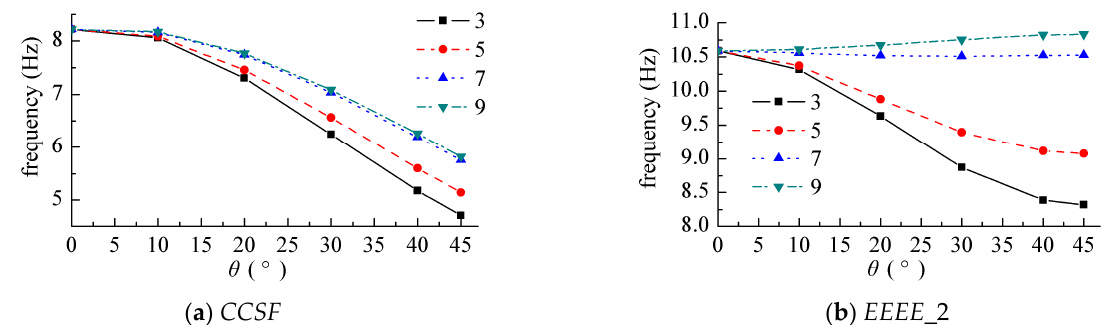
Figure 11. Natural frequency parameters for symmetric angle-ply laminates. ( a ) CCSF, ( b ) EEEE _2.